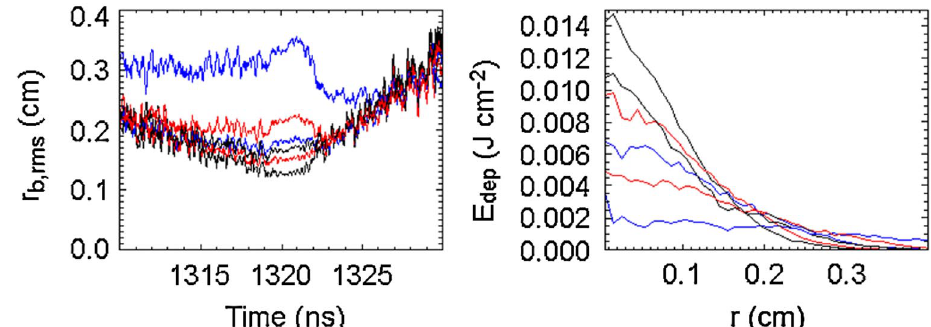
(cid:9) t (cid:10) (left) and radial profiles of cumulative E b (cid:6) (cid:1) 32 : 3 mrad and n r